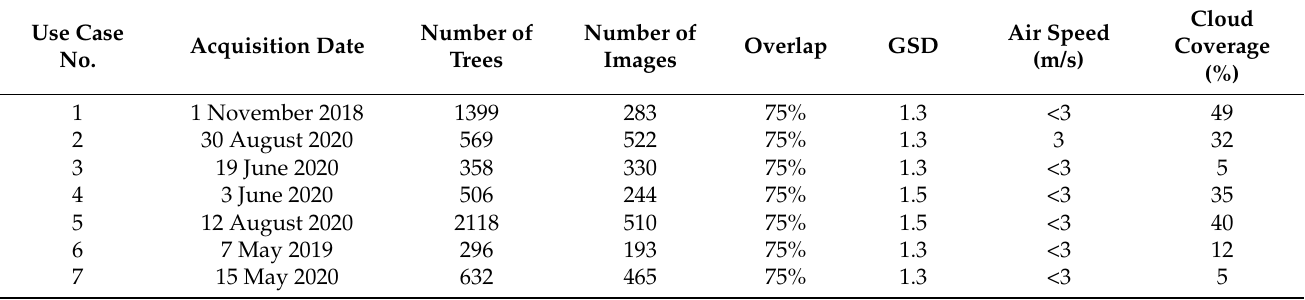
Table 2. Information concerning the flights performed in each use case for the acquisition of images and the creation of the orthomosaics used in the